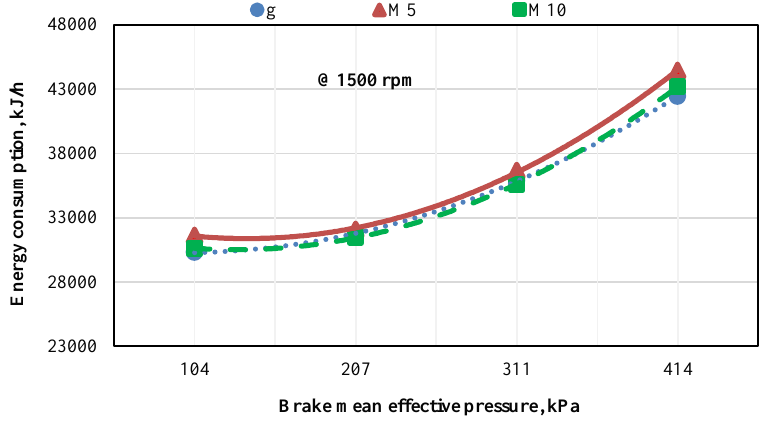
Fig. 4. Energy consumption per hour of the engine for tested fuels at different